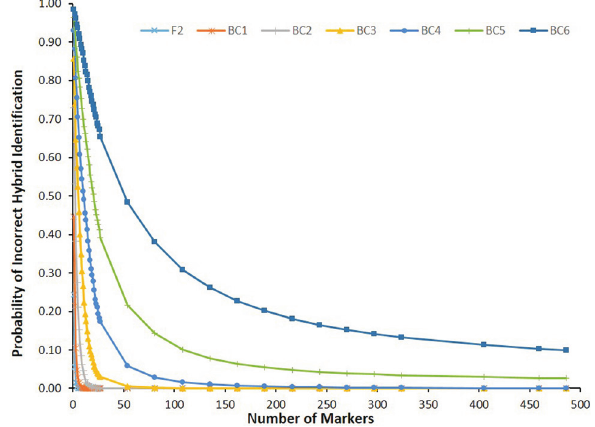
Figure 5 - Probability of incorrect identification of hybrid individuals ob- served in different types of simulated inter and backcross populations, considering increasing numbers of diagnostic